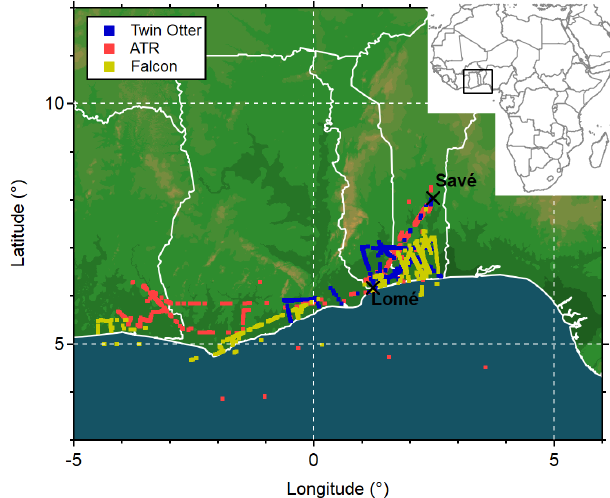
Figure 1. Map showing the parts of the flight trackers where air- borne cloud measurements were made below 1km above mean sea level. The locations of Lomé and Savé are marked as many research flights took place between these two